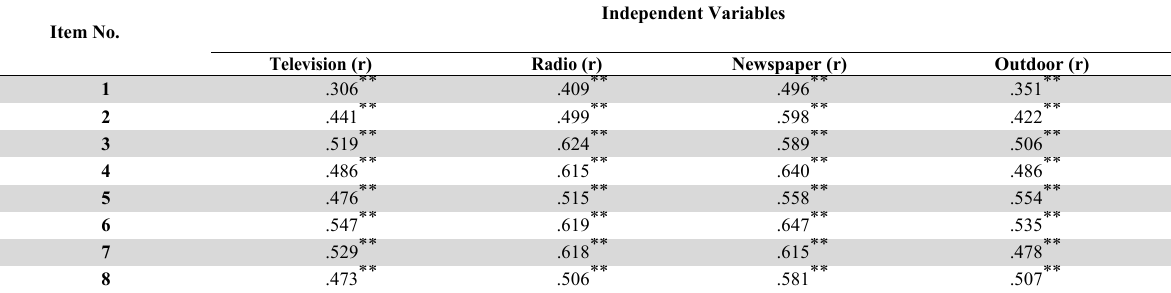
The validity test for the items of independent